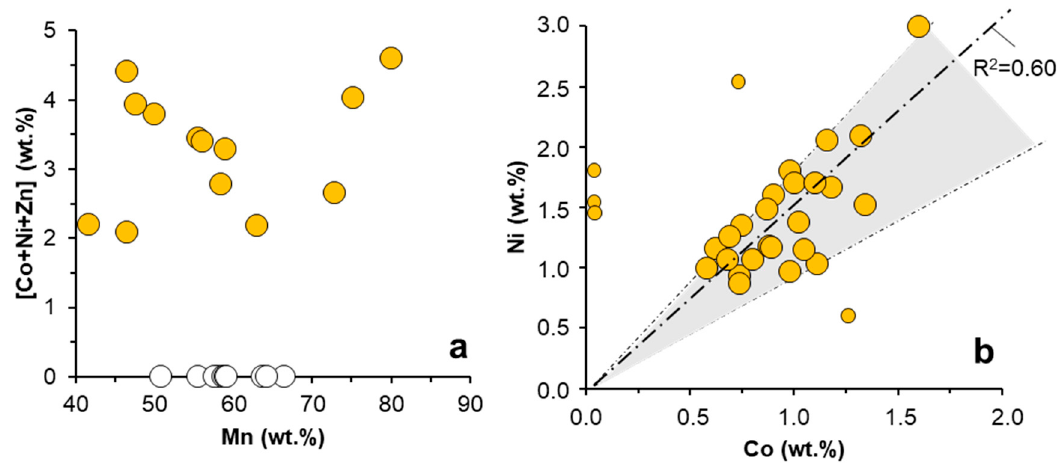
Figure 4. [Co + Ni + Zn] vs. Mn content ( a ) and Ni vs. Co content ( b ) measured by SEM–EDX in manganese oxides formed during Mn(II) oxidation in different mine waters. Orange circles are analyses conducted in asbolane globular aggregates from La Zarza mine water (see Figure 3c,d) whereas white circles correspond to measurements on manganite nanocrystals formed in AMD from Brunita mine (Figure 3e,f), and on birnessite crystals from Guadiana mine water (Figure 3a,b). The regression line plotted in ( b ) only considers the points in the shaded area (i.e., outliers excluded).